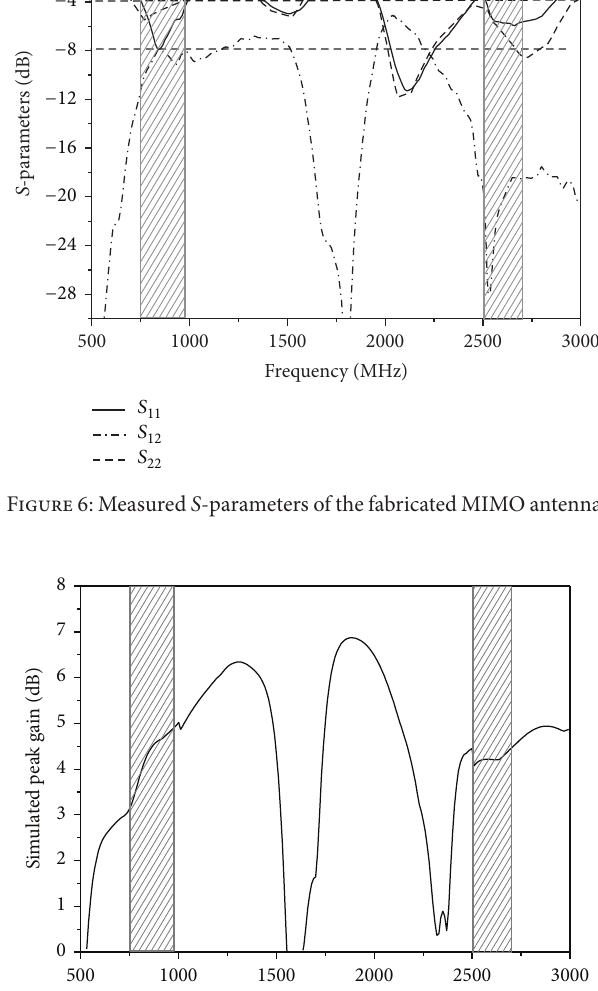
Figure 7: Simulated peak gain of the fabricated MIMO antenna.